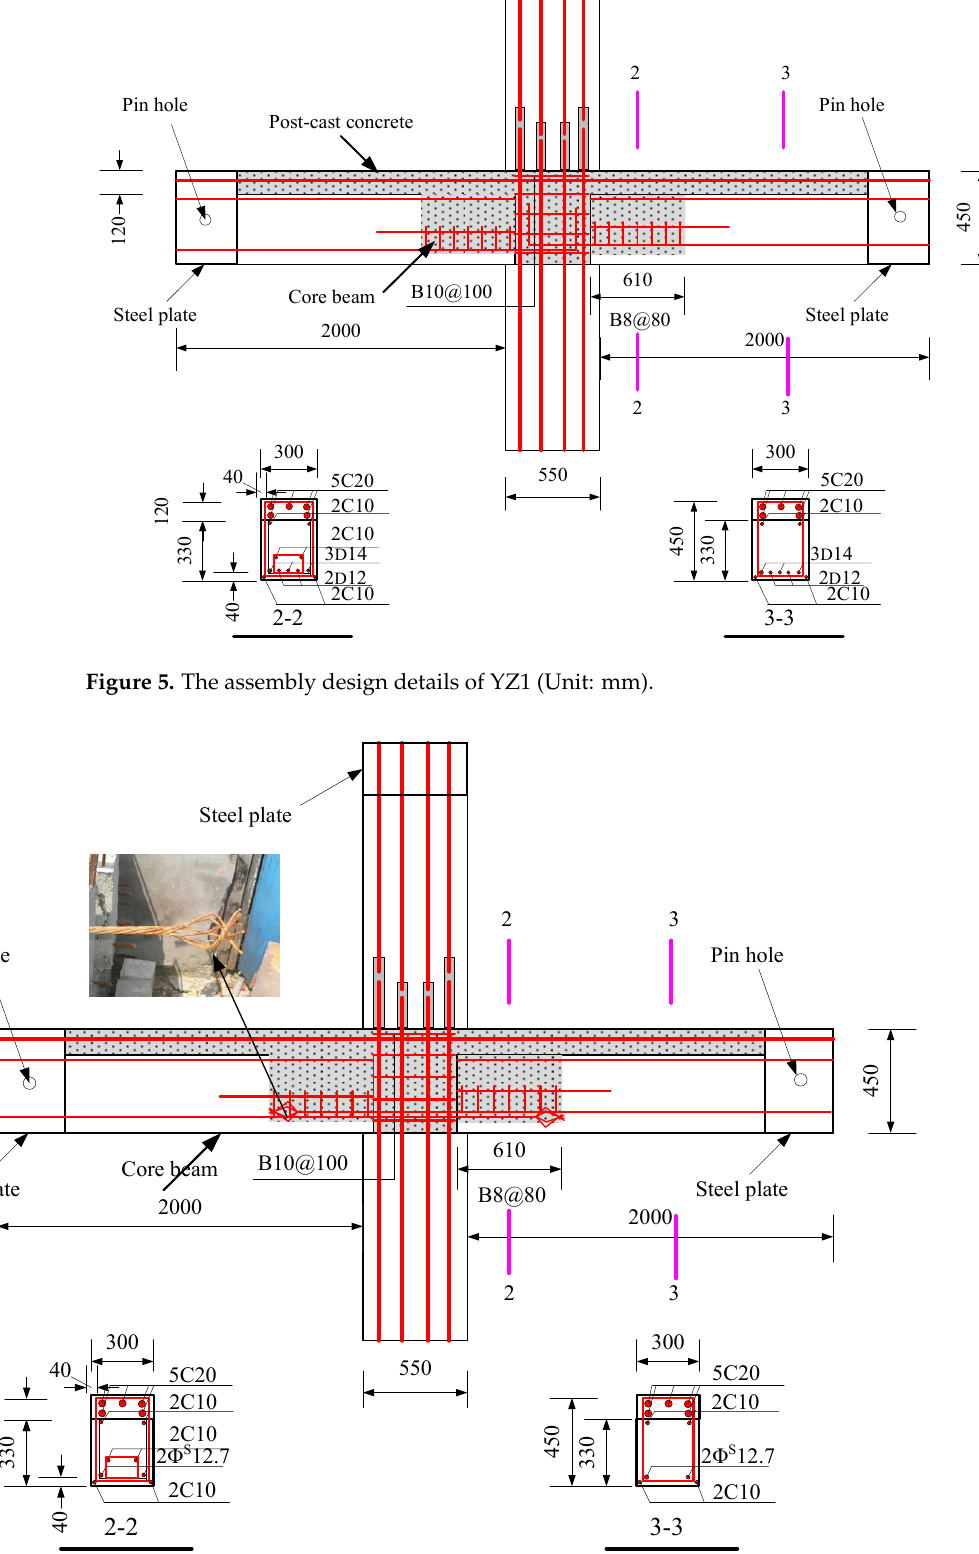
Figure 6. The assembly design details of YZ2 (Unit: mm).